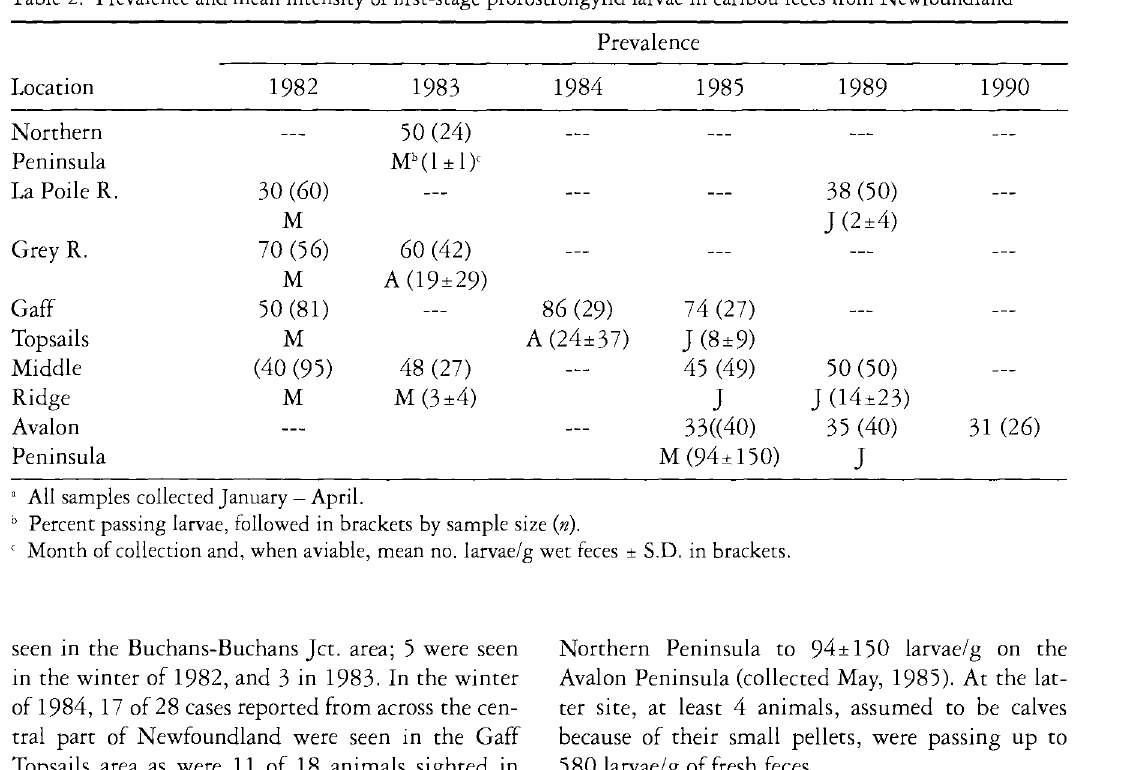
Table 2. Prevalence and mean intensity of first-stage prorostrongylid larvae in caribou feces from Newfoundland*